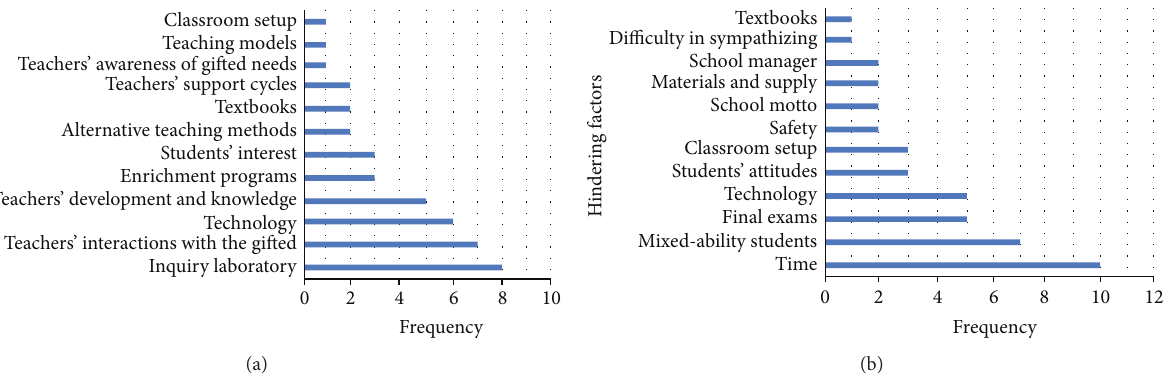
Figure 1: Frequency of helping (a) and hindering (b) factors listed in teachers’ photonarratives.